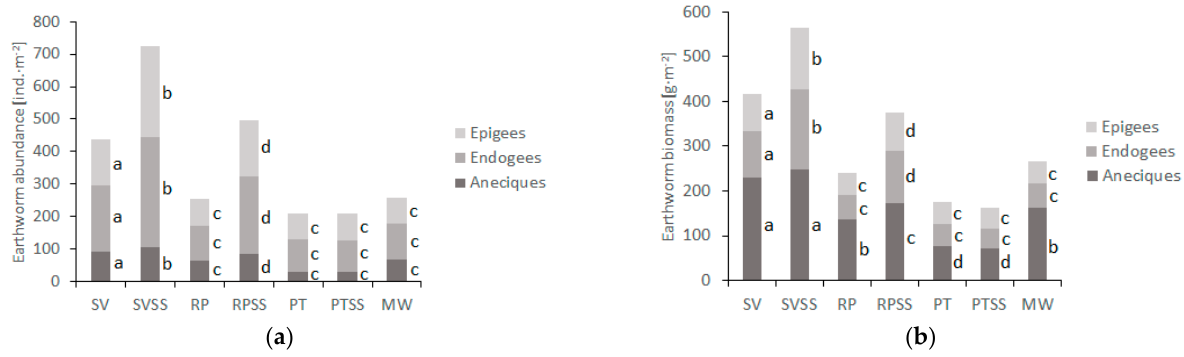
Figure 2. Density ( a ) and biomass ( b ) of earthworms in the cultivation treatments based on ecological groups. (Abbreviations of cultivation treatments are as given in Table 1). Different letters within individual ecomorphological groups of Lumbricids indicate statistically significant differences ( p < 0.05).